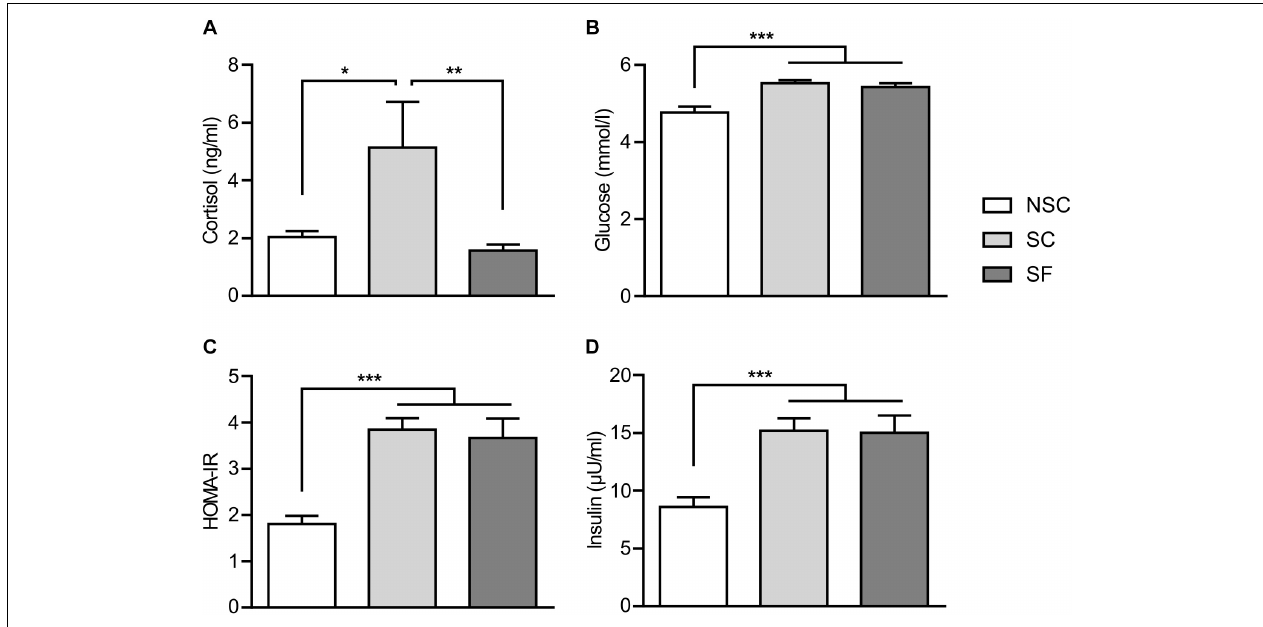
FIGURE 3 | Plasmatic markers. At 3 weeks of stress and treatment, stressed animals (SC) had a higher level of salivary cortisol than non-stressed (NSC) and stressed-treated (SF) animals (A) [ F (2,28) = 6.882, SC/NSC: p = 0.20, SC/SF: p = 0.001]. N = 11/group. The levels of glucose (B) , insulin (D) , and the insulin resistance index HOMA-IR (C) were significantly higher in SC and SF compared to NSC [respectively, F (2,23) = 3.429, F (2,24) = 9.458, F (2,23) = 12.657, NSC/SC, and NSC/SF: p < 0.001]. N = 10/group, mean ± SEM, two-way ANOVA, ∗ p < 0.05, ∗∗ p < 0.01, and ∗∗∗ p < 0.001.